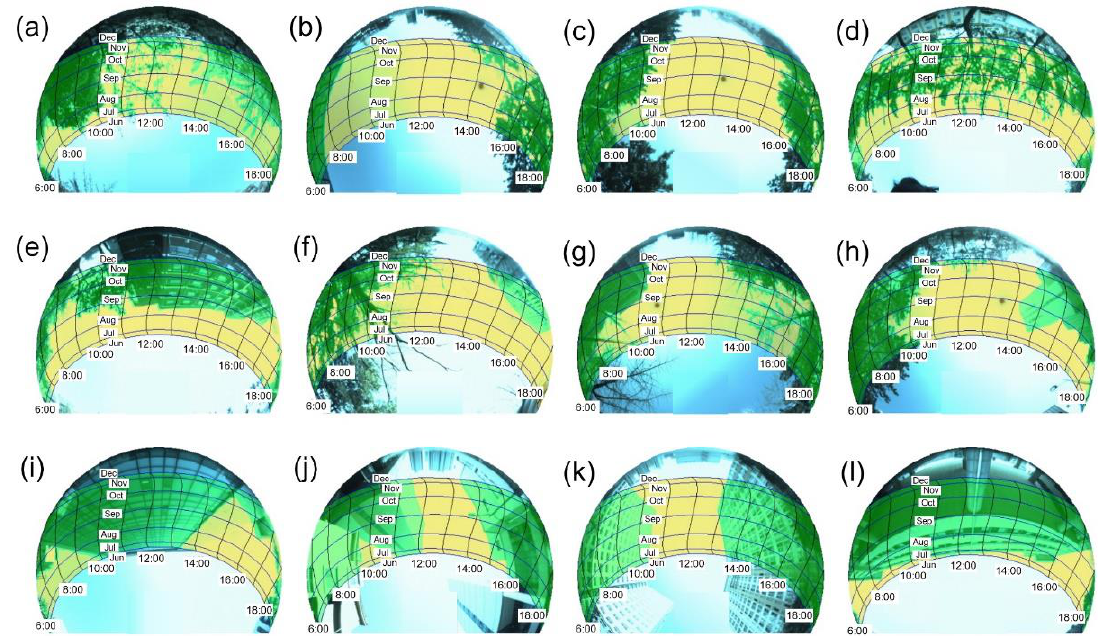
Figure 10. Fisheye images overlaid with sun-path diagram. Yellow and green areas represent open sky and shading obstructions (i.e., roadside trees and buildings), respectively. Case A: survey points surrounded by only roadside trees ( a ) A1; ( b ) A2; ( c ) A3; ( d ) A4; Case B: survey points surrounded by buildings and trees ( e ) B1; ( f ) B2; ( g ) B3; ( h ) B4; Case C: survey points surrounded by only buildings ( i ) C1; ( j ) C2; ( k ) C3; ( l ) C4.